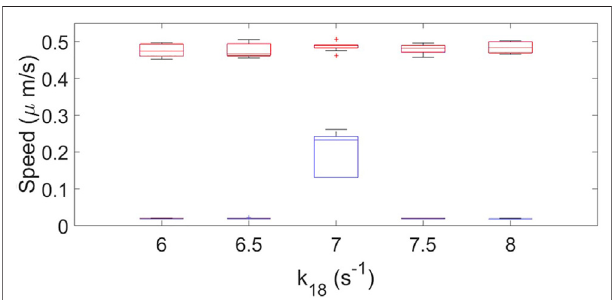
Figure 4 for the no mass conservation case and for Figure 6 for the mass-conservation system.